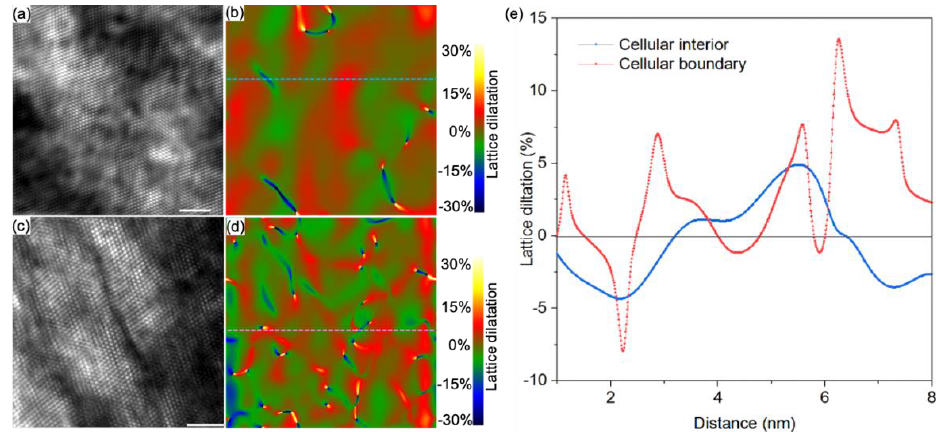
Figure 5. Dislocation structures in an MCS. ( a ) IFFT image of cellular interior taking along the [110] zone axis, ( b ) its GPA map showing dislocation cores with (111) frequency. ( c ) IFFT images of the cellular boundary, and ( d ) its GPA map. The color legend for GPA map indicates ε xy induced by dislocations. ( e ) The local ε xy corresponding to dash lines marked in ( b , d ). The scale bar is 2